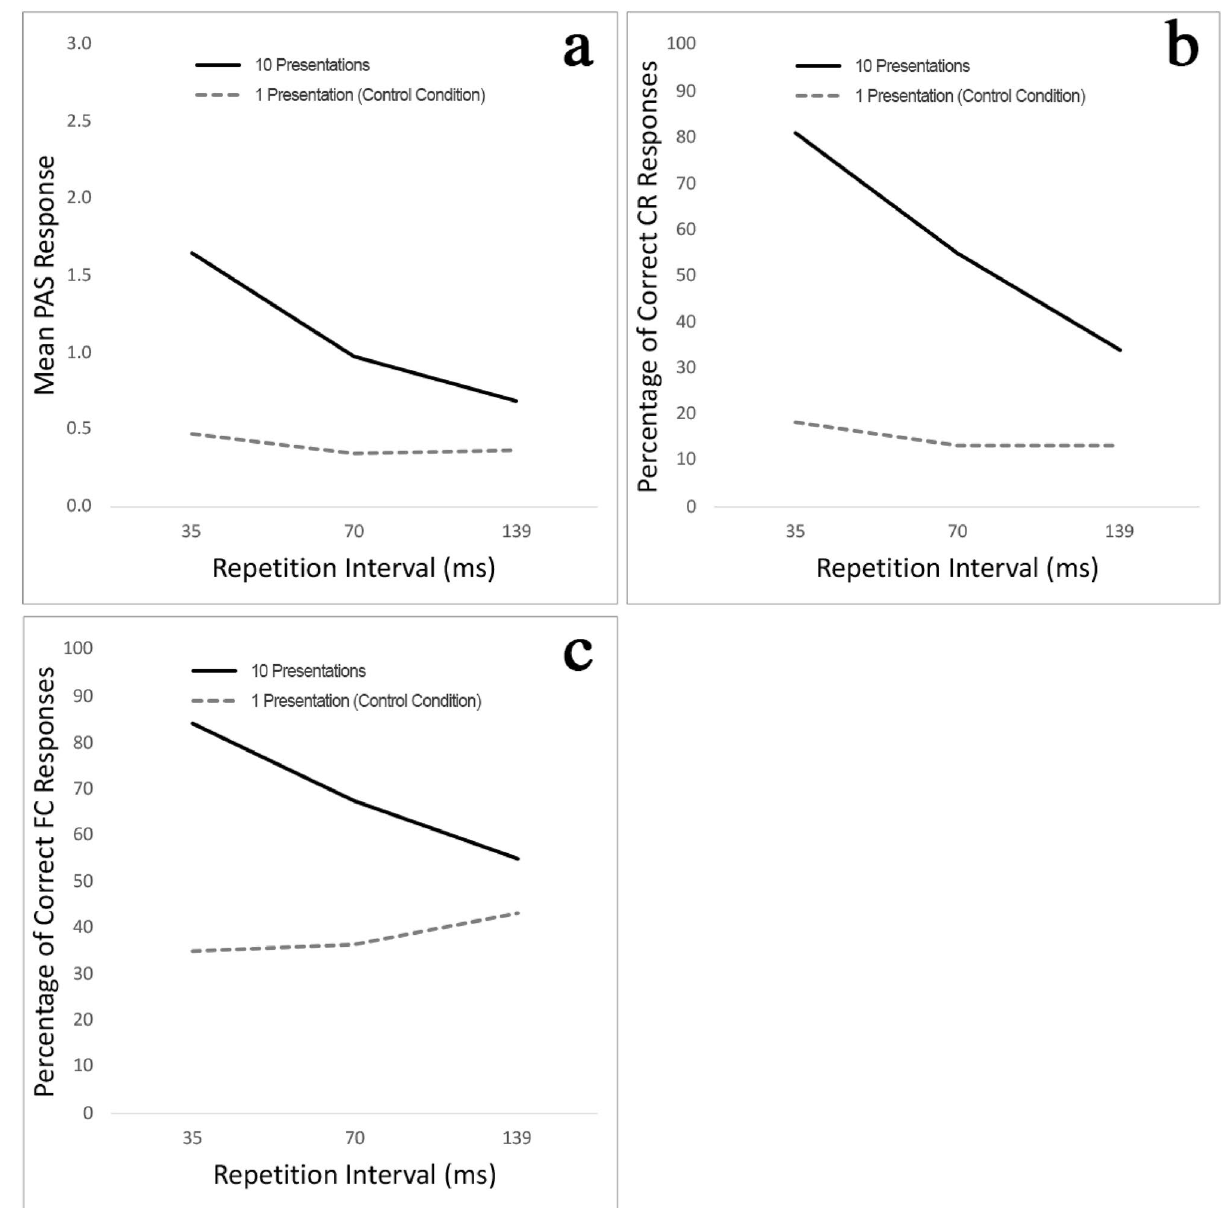
Figure 3. Experiment 2 results. More data points for each number of target presentation and repetition interval pair and stronger masking corroborated the findings from Experiment 1: Repetition had a significant impact on PAS reports ( a ), as well as the percentage of correct CR ( b ) and FCT responses ( c ). Repetition interval length had a significant impact on perception even among relatively short